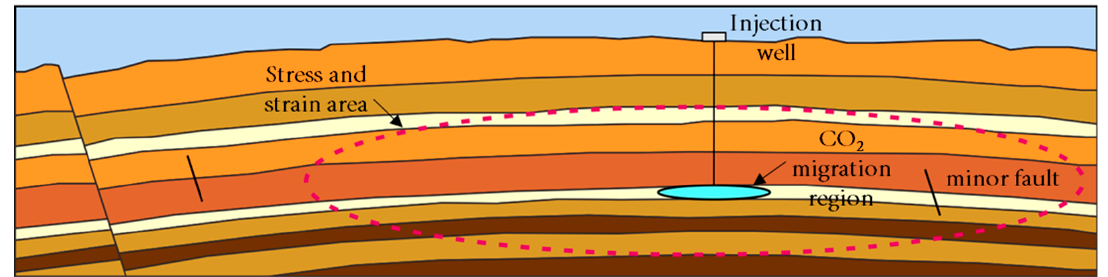
Figure 2. Schematic diagram of reservoir changes after CO 2 injection into the reservoir (modified from Rutqvist J, 2012 [9]).